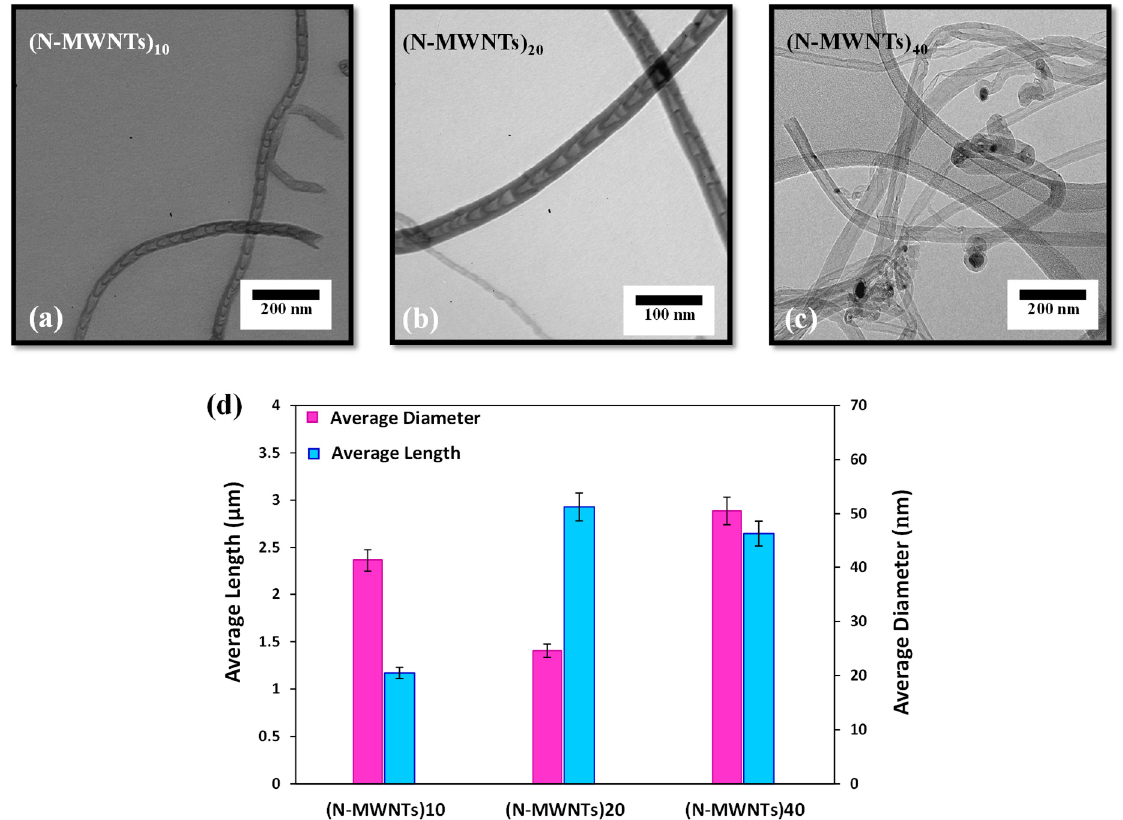
Figure 1. ( a – c ) TEM images of N-MWNTs grown over different ratios of catalyst, ( d ) average diameter and length of N-MWNTs synthesized over different catalysts.